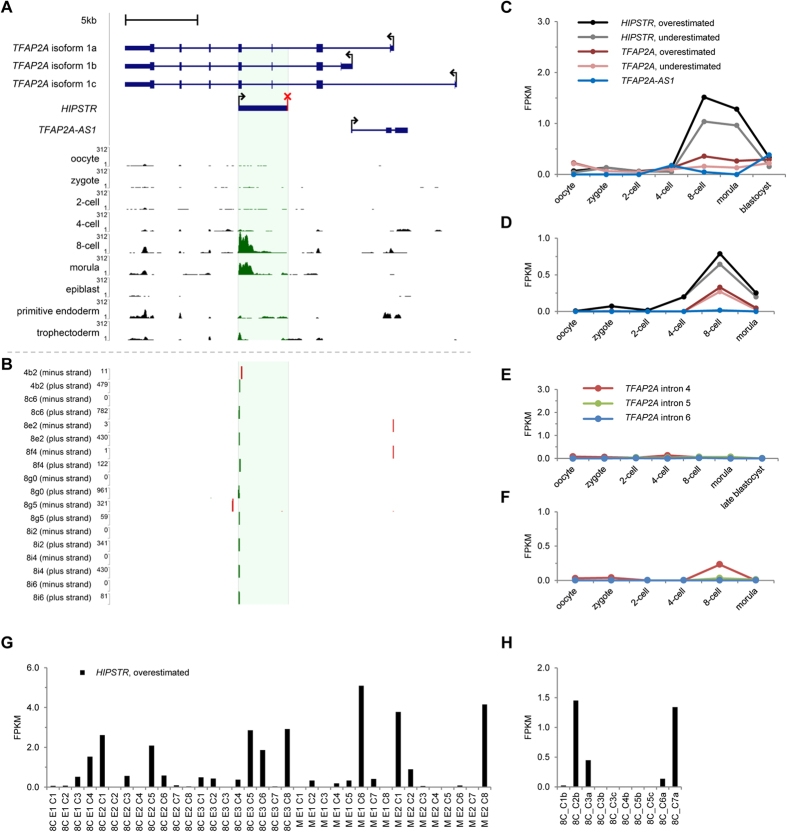
HIPSTR is expressed by a subset of cells in early human embryos.(A) Mapping of RNA-seq reads from ref. 7 illustrates specific expression of HIPSTR, and not TFAP2A or TFAP2A-AS1, in 8-cell and morula-stage human embryos. (B) Mapping of the 5′-ends of transcripts with strand-specific STRT-seq data from ref. 51 shows specific expression of HIPSTR in one cell (4b2) from a 4-cell human embryo, and in eight cells (8c6 through 8i6) originating from five different 8-cell human embryos; cell names are as in ref. 51. (C,D) Re-analyses of aggregate RNA-seq data for each developmental stage from ref. 7 on (C), and from ref. 50 on (D) confirms that HIPSTR induction in early embryos is independent from TFAP2A and TFAP2A-AS1 genes. (E,F) TFAP2A pre-mRNA is not detectable in human oocytes and early embryos; re-analyses of aggregate RNA-seq data from ref. 7 on (E), and from ref. 50 on (F). (G,H) HIPSTR expression is restricted to a subset of cells in early human embryos, as inferred from RNA-seq data for 8-cell- and morula-stage embryos from ref. 7 in (G), or RNA-seq data for 8-cell-stage embryos from ref. 50 in (H); plotted are overestimated FPKM values for HIPSTR expression (see text).